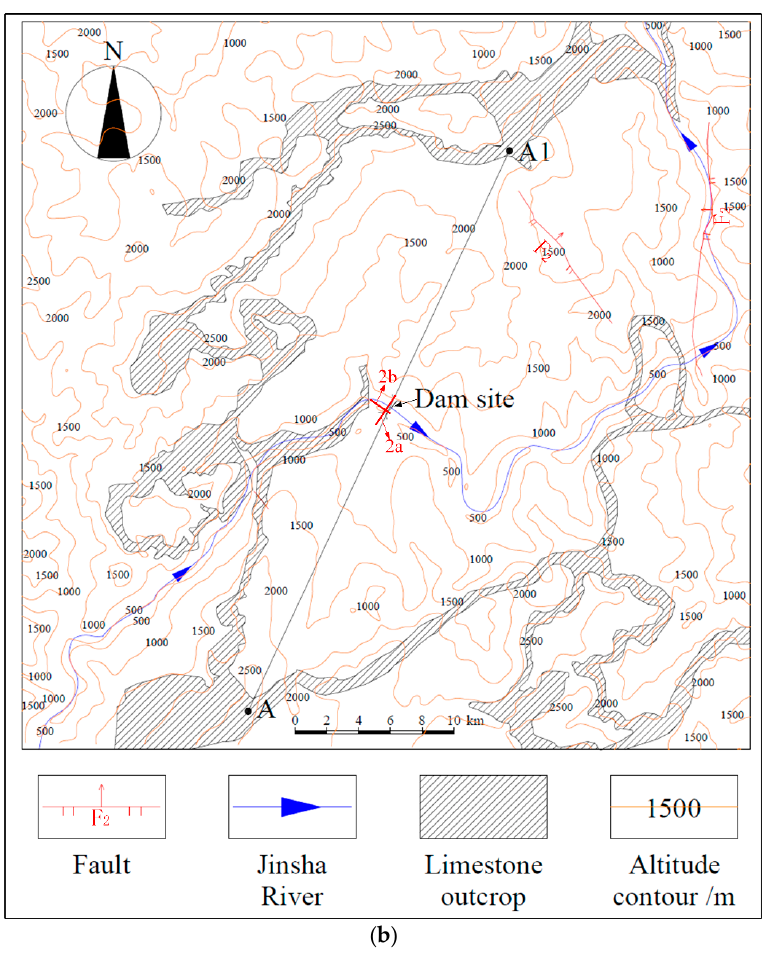
Figure 1. Overview of the Xiluodu Project: ( a ) regional location of Xiluodu Project; ( b ) outline of the limestone outcrops.